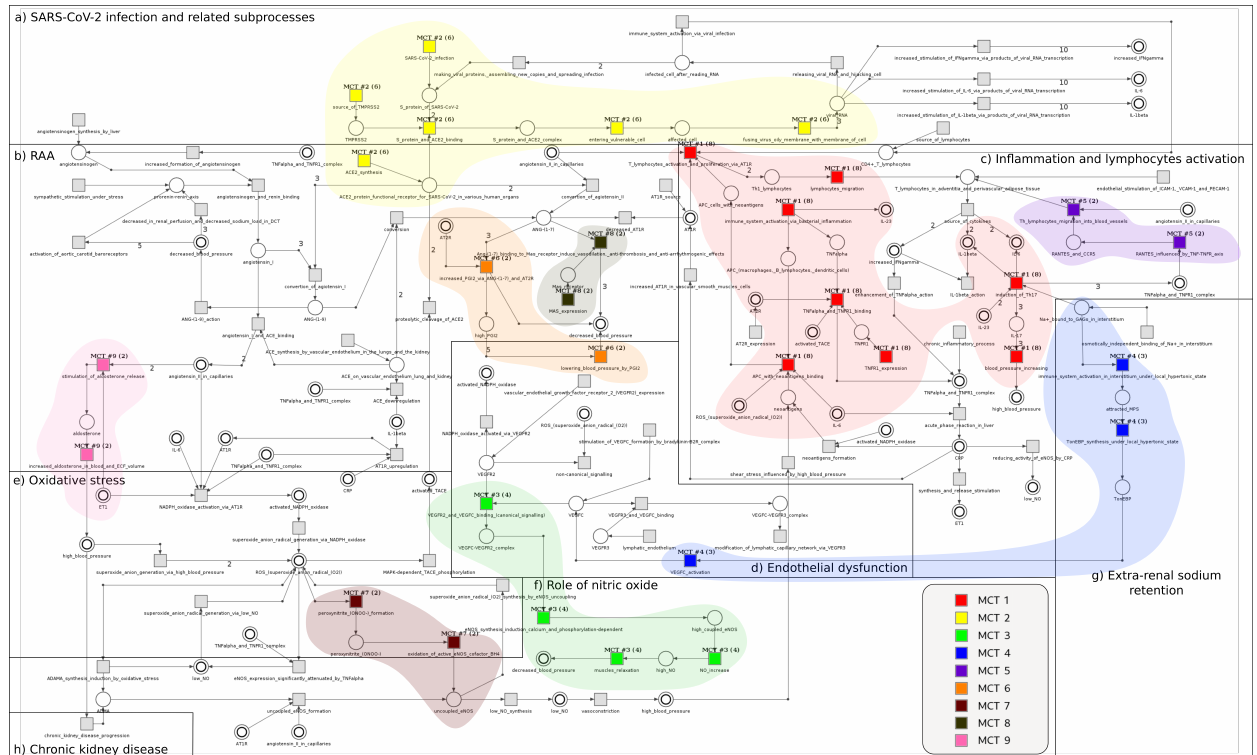
Figure 3. A graphical representation of the MCT sets for the t-invariants solely associated with SARS-CoV-2